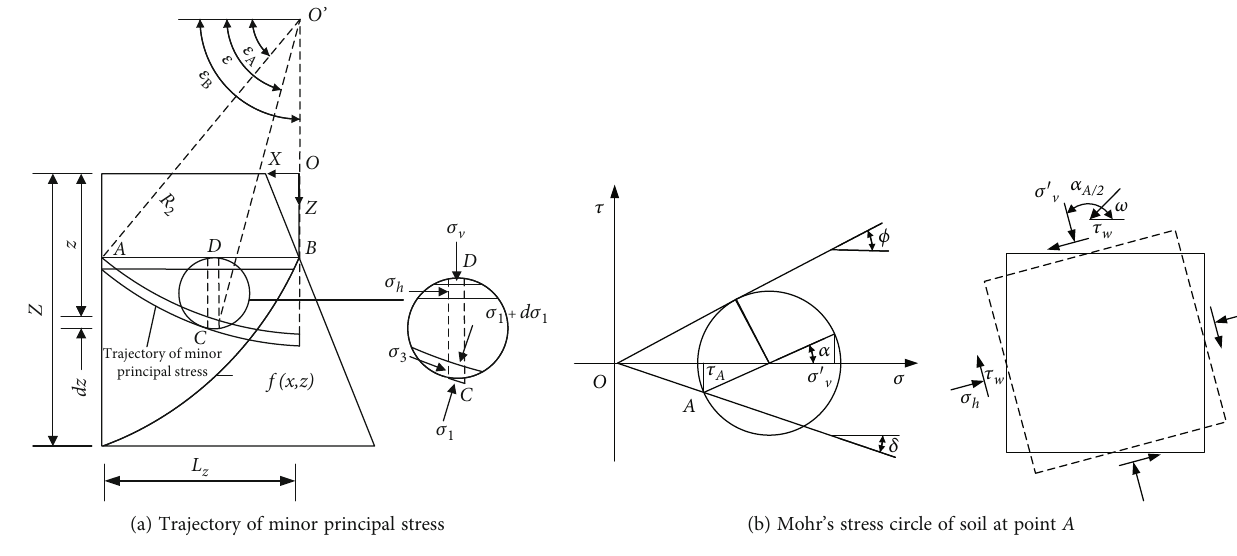
Figure 3: Stress analysis of soil